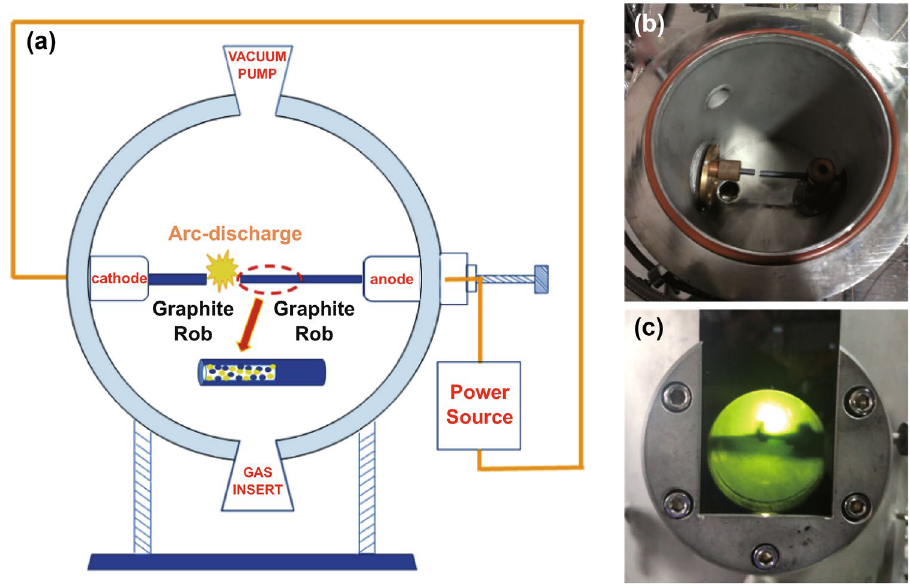
Fig. 1 a Schematic diagram of the arc discharge process and b digital image of the arc discharge system; c typical photograph of the arc